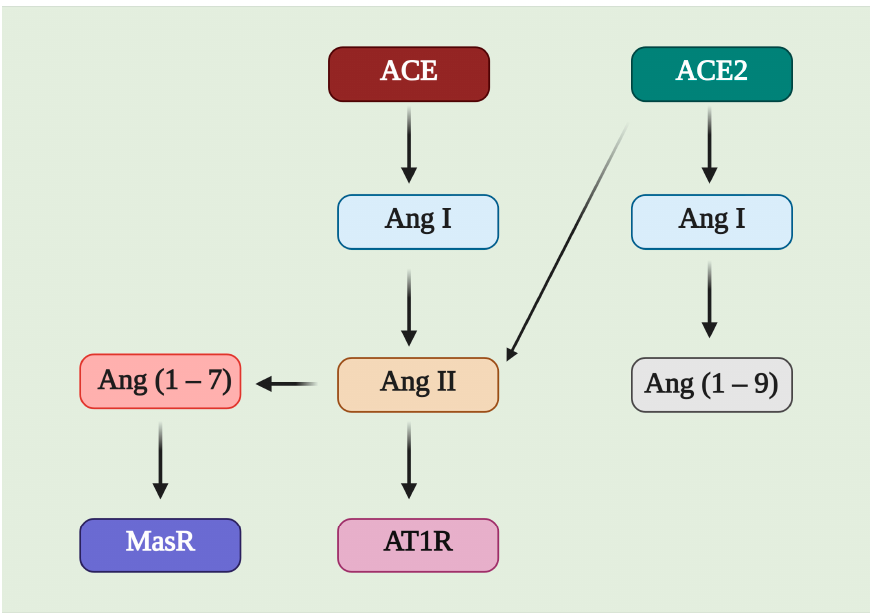
Figure 3. Image of the possible substrates and products of Angiotensin-Converting Enzyme 2 (ACE2). ACE2 can affect Ang I and Ang II, producing Ang (1–9) and Ang (1–7), respectively. Ang (1–7) is a molecule with affinity for the Mas receptor (MasR), while Ang II is related to angiotensin II type 1 receptor (AT1R).